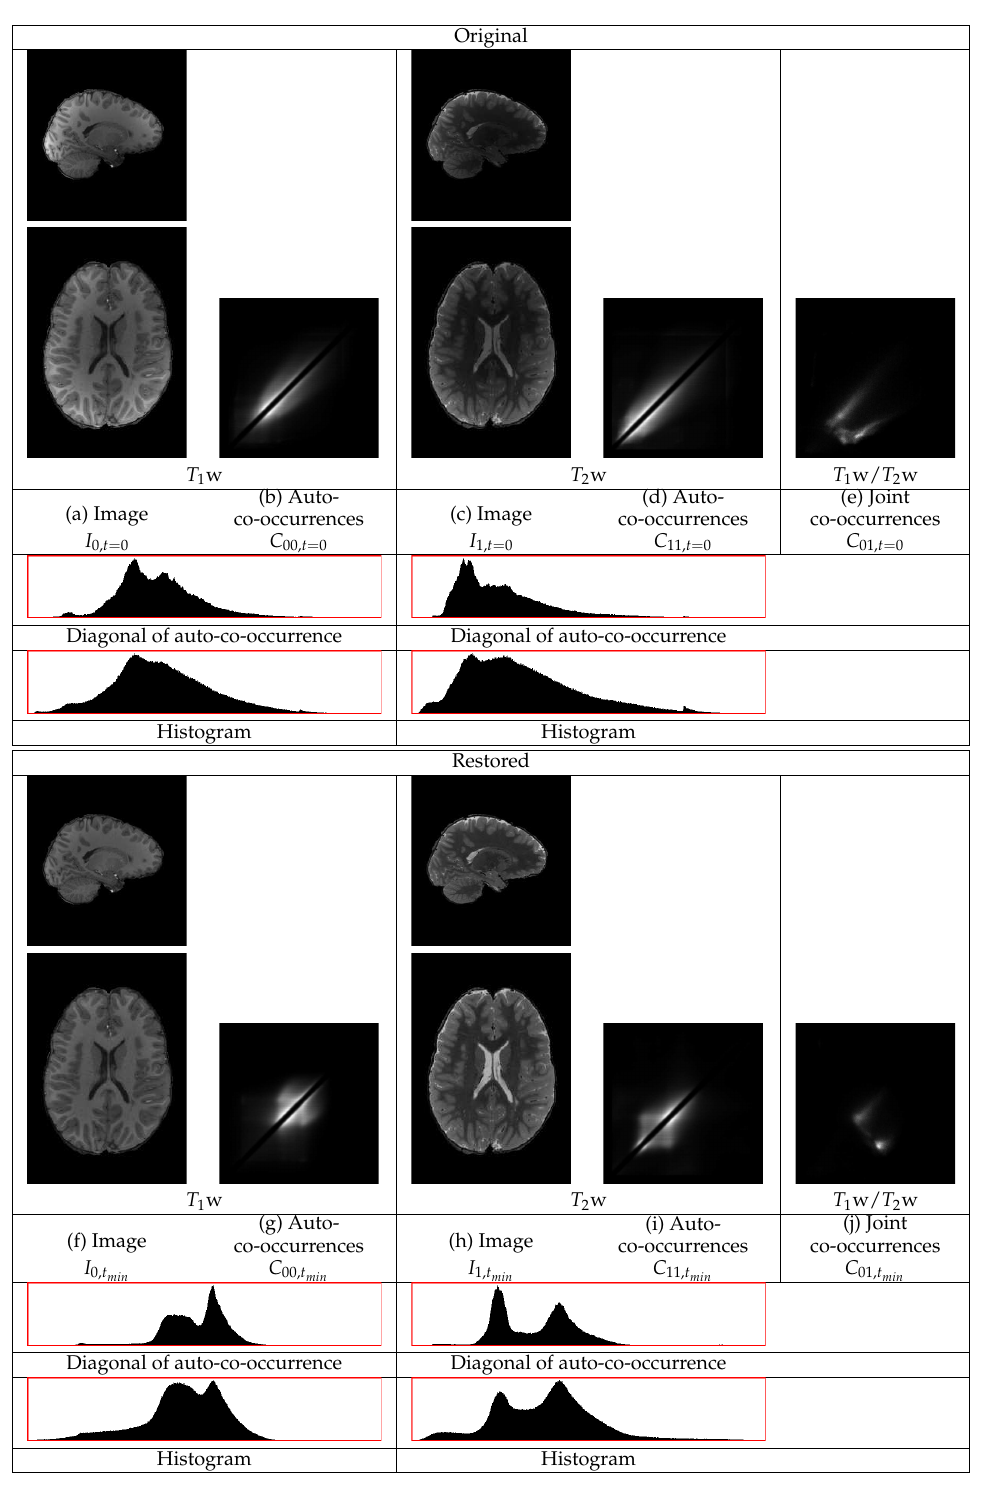
Figure 6. Example restoration of a T 1 w and a T 2 w image pair for the HCP LS dataset. The intensities of the white matter and the gray matter in both the T 1 w image and in the T 2 w image become more uniform. The statistical distributions become